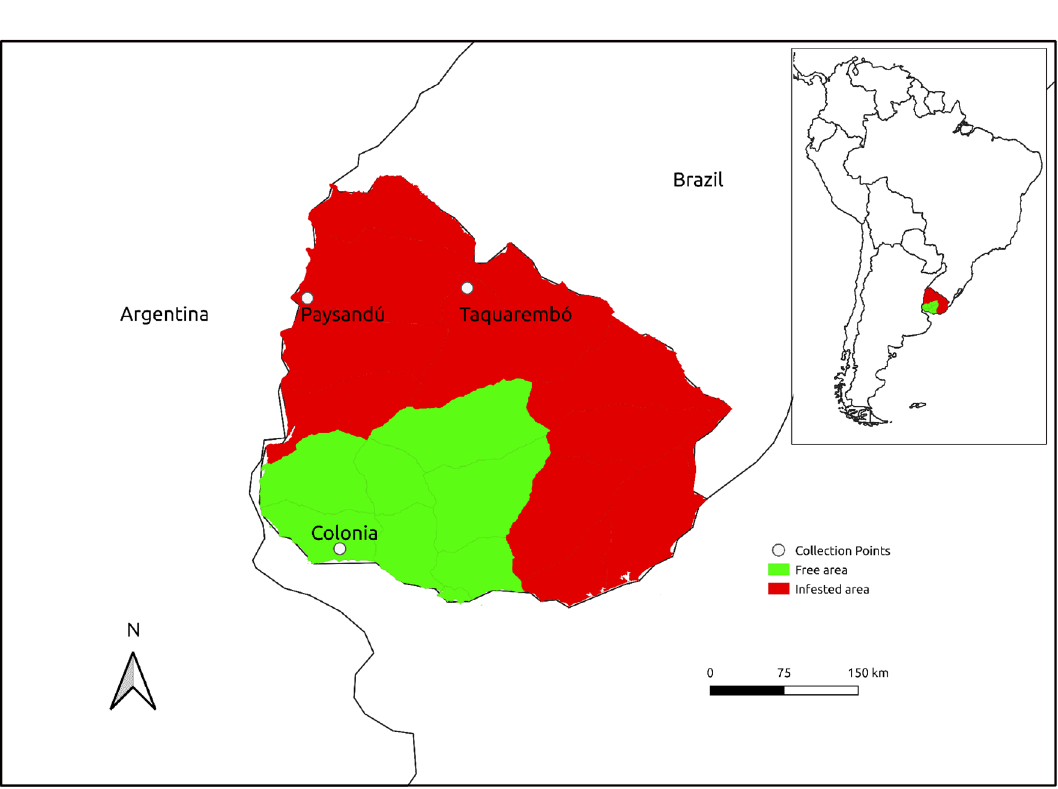
Figure 2. Locations of horsefly collections in tick-free and tick-infested areas of Uruguay. The map was created using QGIS 3.22.11 (http:// qgis.